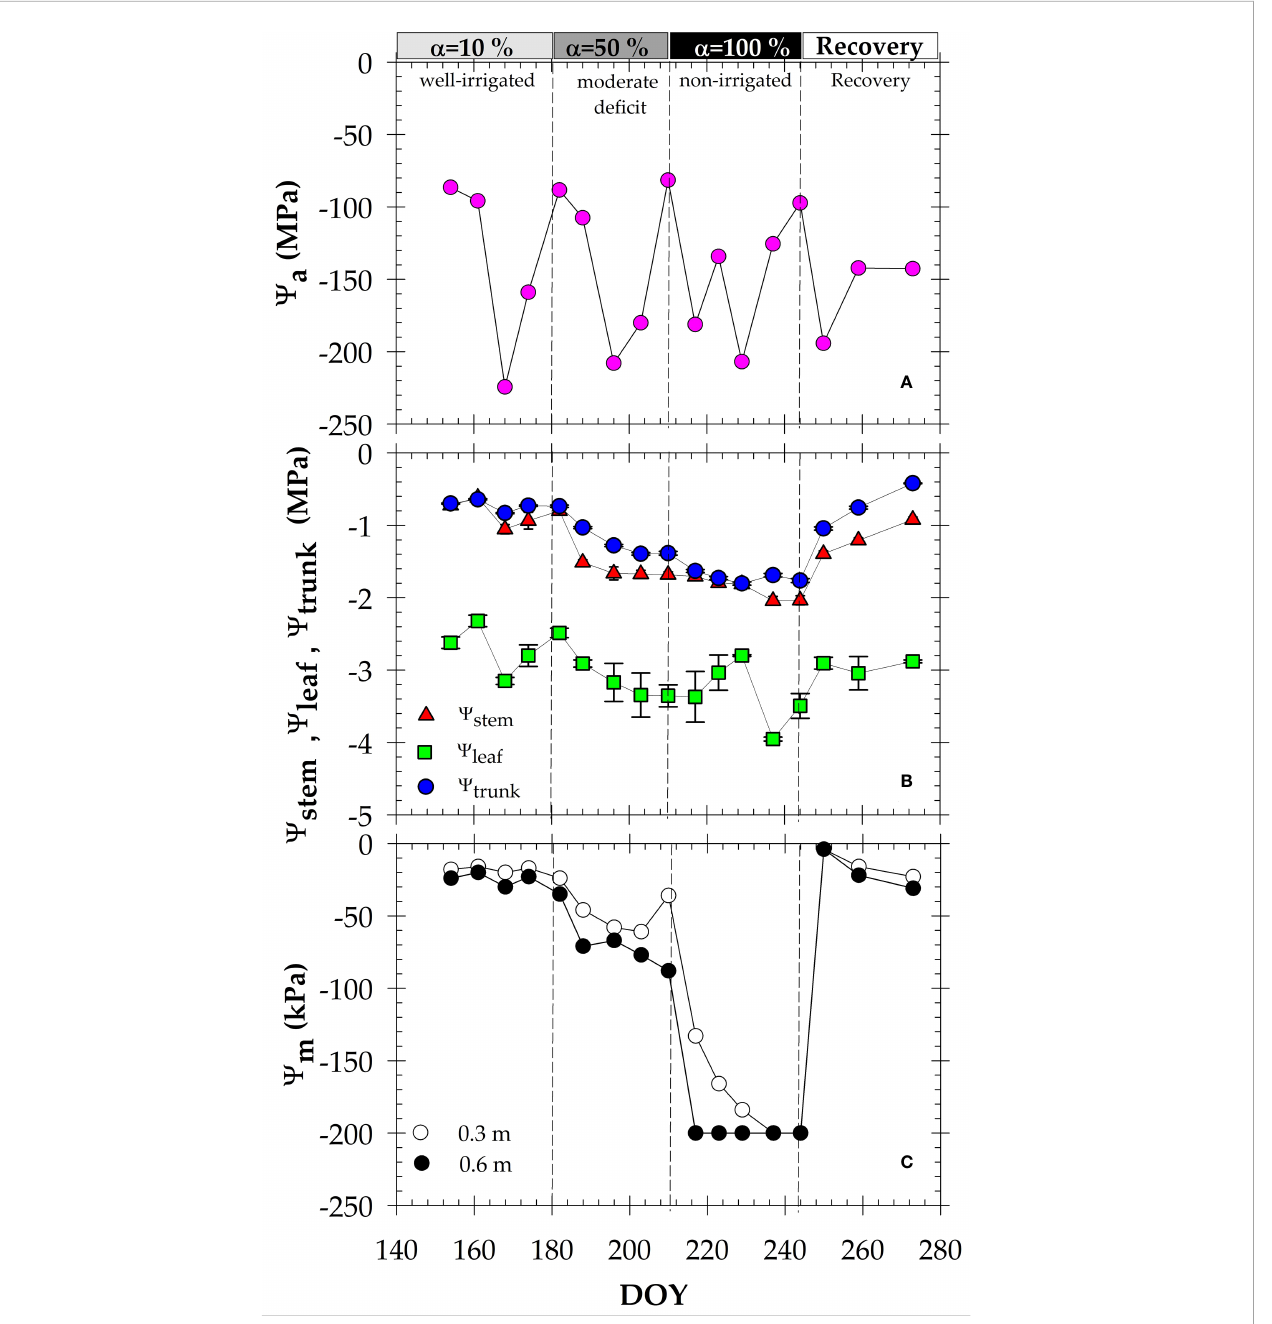
FIGURE 2 Seasonal course of: (A) daily mean air water potential ( Y air ); (B) midday stem ( Y stem ), leaf ( Y leaf ) and trunk ( Y trunk ) water potentials, and (C) soil matric potential ( Y m ) at 0.3 and 0.6 m of the soil pro fi le. Each point is the average of four leaves, two MTs, and two granular matrix sensors. Vertical bars at data points are ± SE (not shown when smaller than the symbols). Dashed vertical lines delimit each irrigation criterion. DOY: Day of the